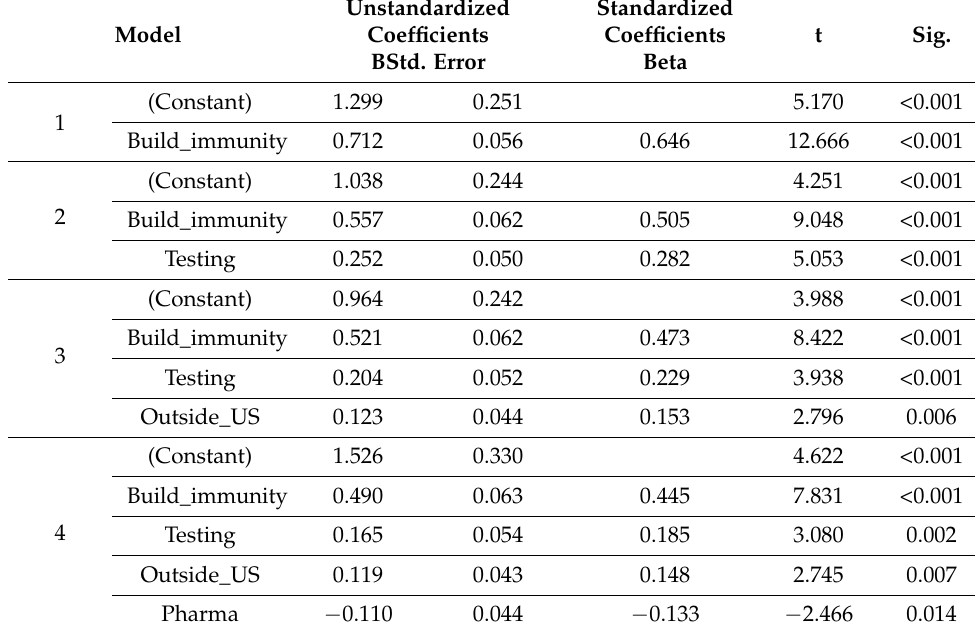
Table 3. Model equation for the linear regression of booster shot